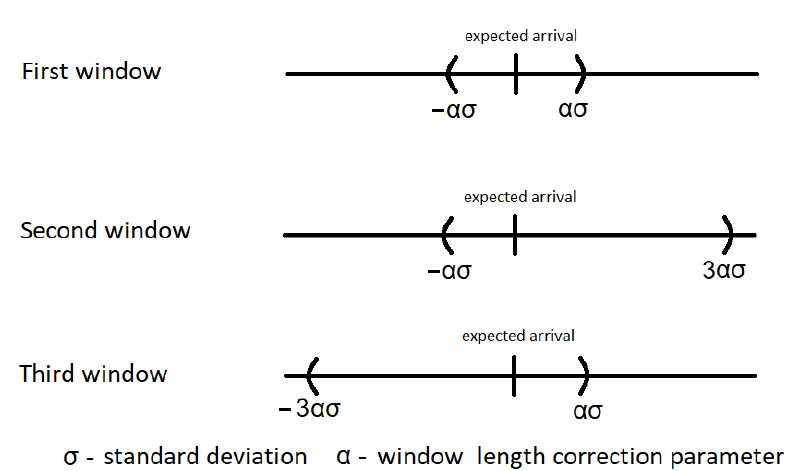
Figure 3. Shifted time